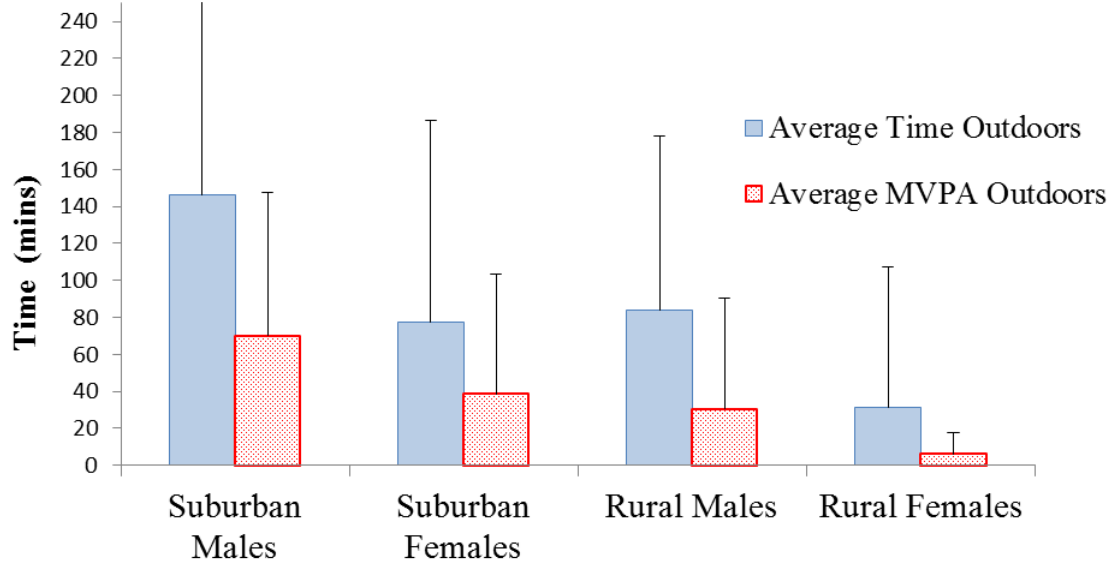
Figure 2. Weekday mean (±SD) outdoor time and physical activity of suburban and rural